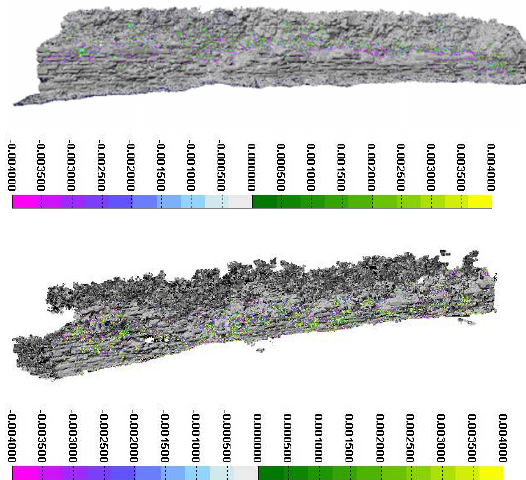
Figure 6. The comparison [m] of a wall between the model derived from Agisoft Photoscan (above) and Visual SfM (below) and the TLS data.